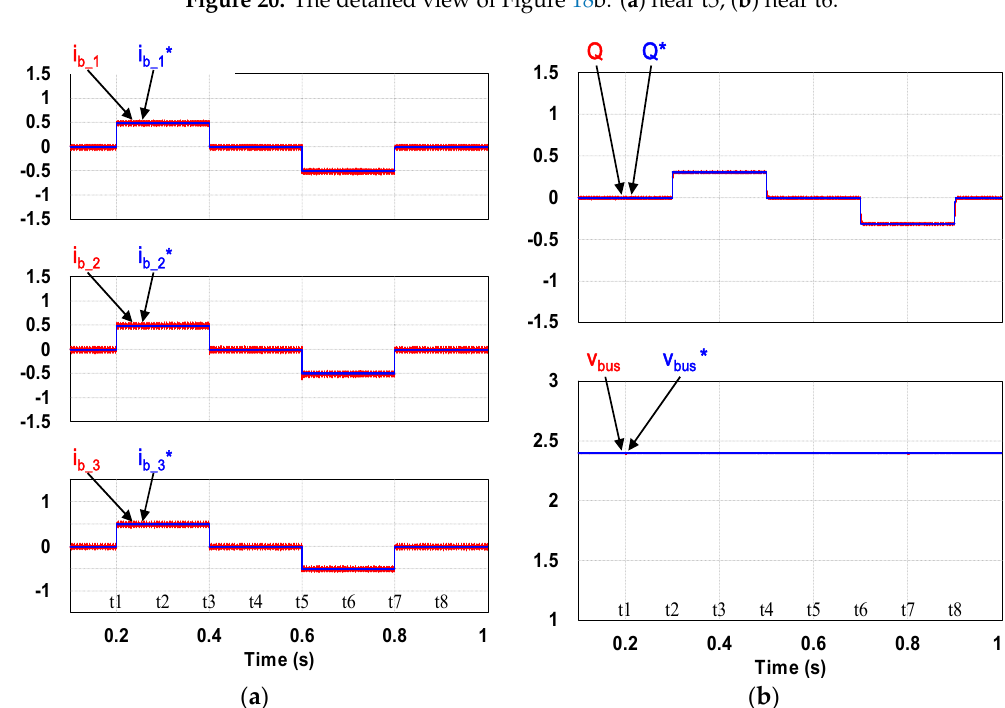
Figure 21. Waveforms of control commands and feedbacks: ( a ) three interleaved inductor currents; ( b ) reactive power (top), DC bus voltage (bottom).